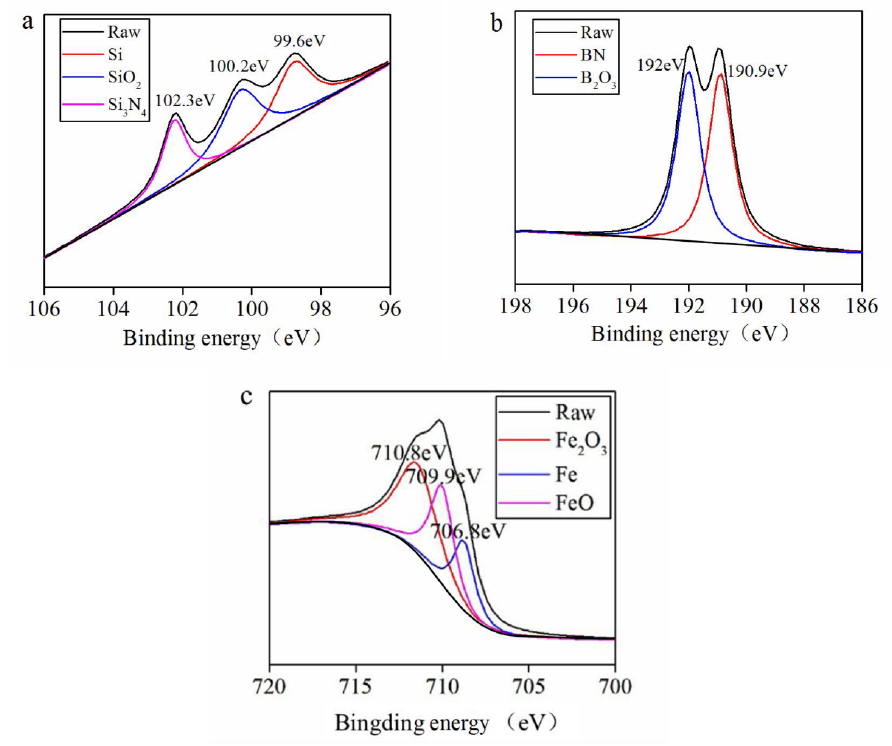
Figure 9. XPS spectrum of Si 2p ( a ), B 1s ( b ), and Fe 2p 3 / 2 ( c ) on the worn surface of the GCr15 disc sliding against the SN10 pin in the seawater environment.